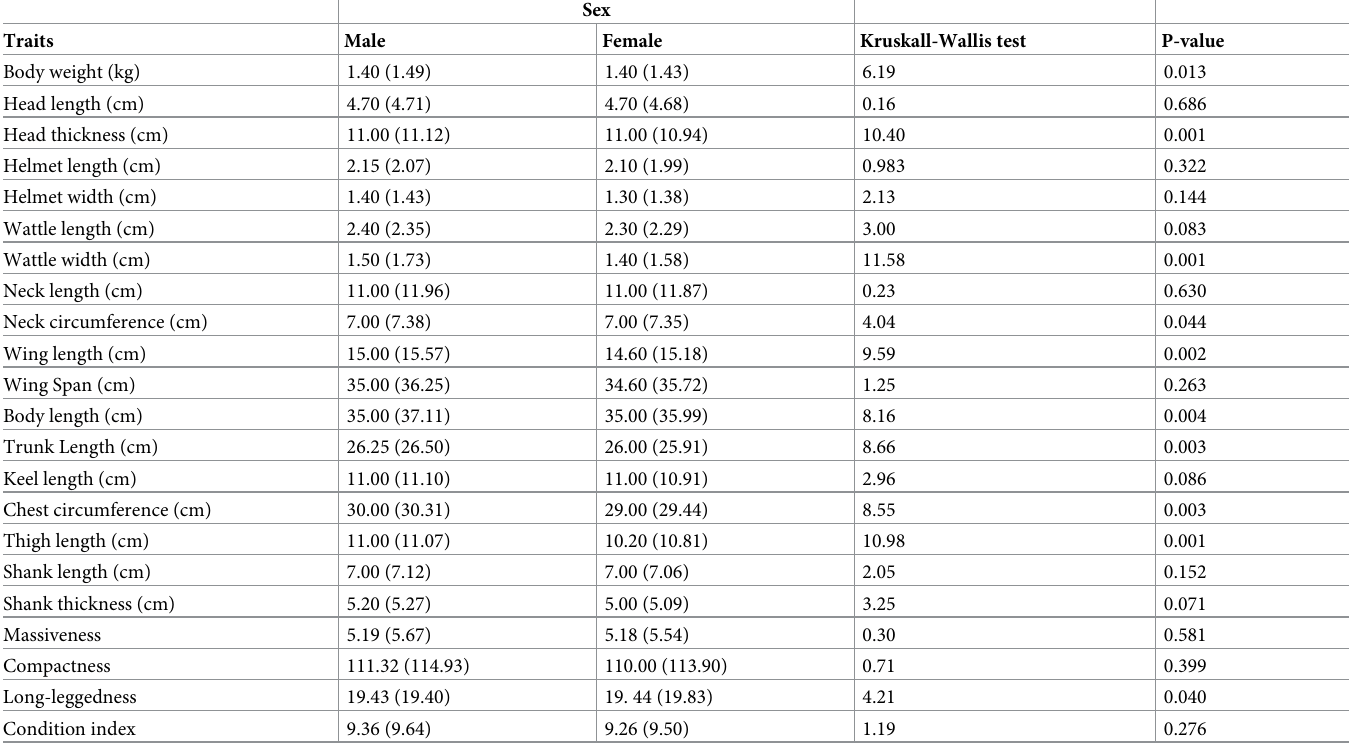
Table 4. Medians (means in parentheses) of biometric traits and morphological indices of indigenous helmeted Guinea fowls based on sex. Sex